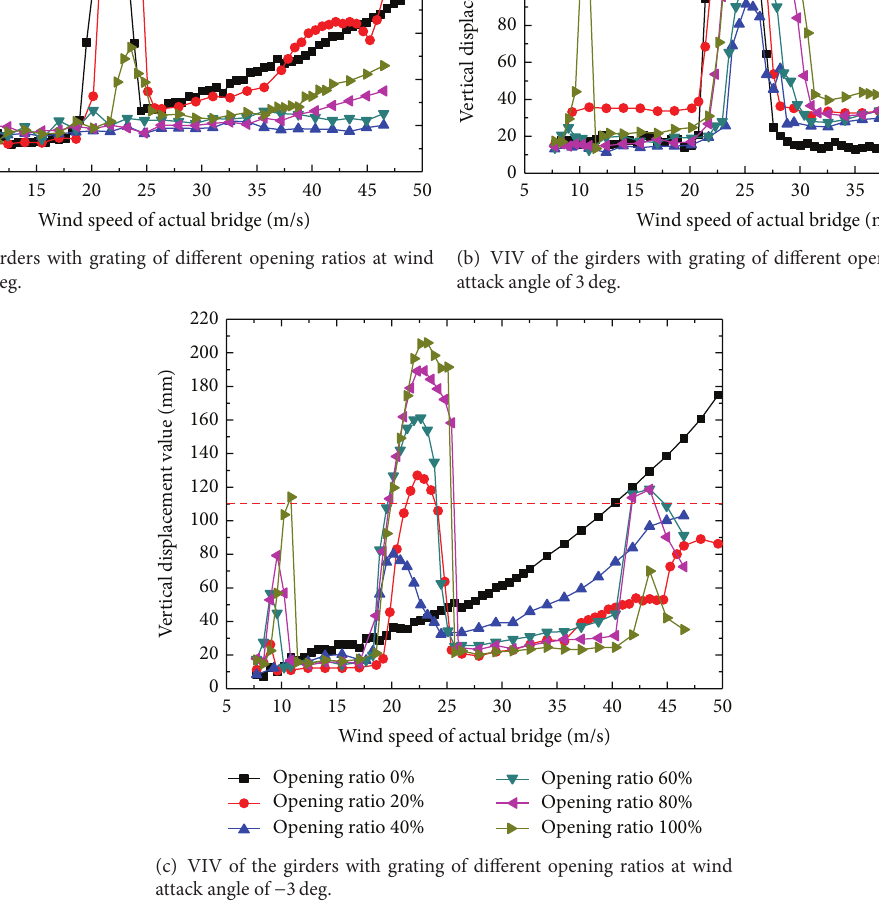
Figure 7: VIV of the girders with grating of different opening